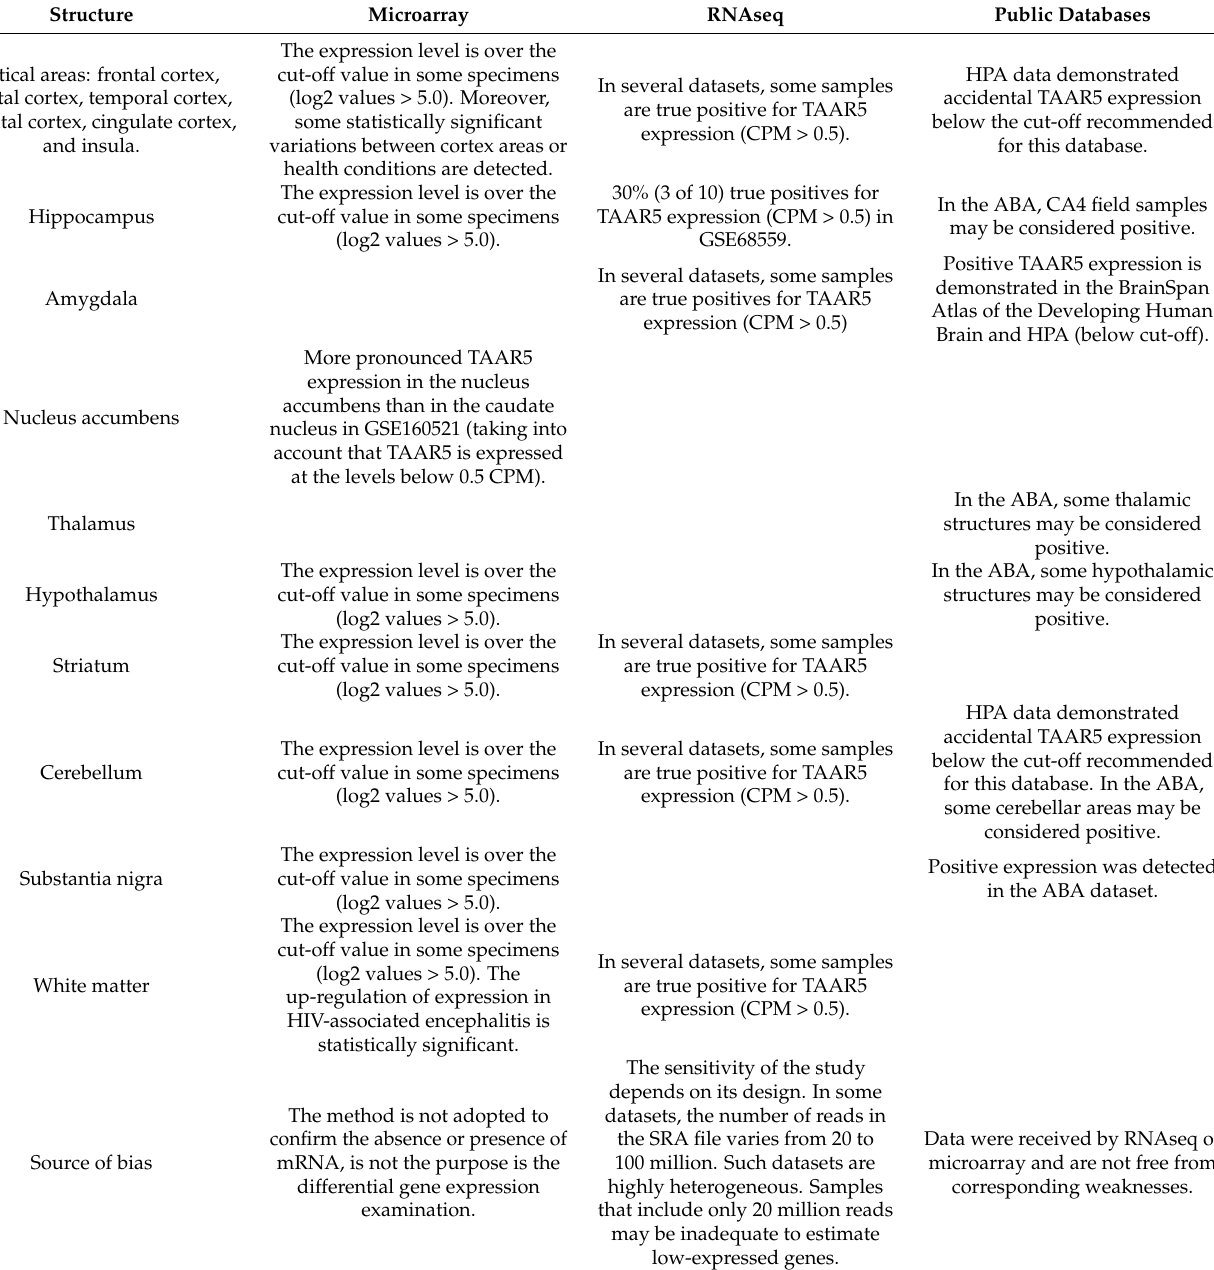
Table 1. Evidence for TAAR5 expression in brain mined by high-throughput data analysis.